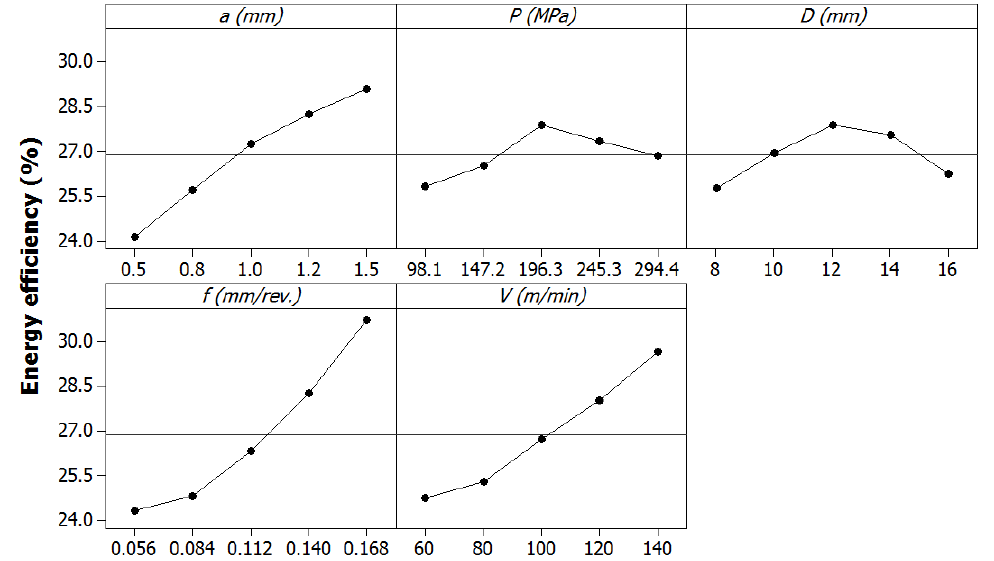
Figure 5. The main effects of machining parameters on energy efficiency.